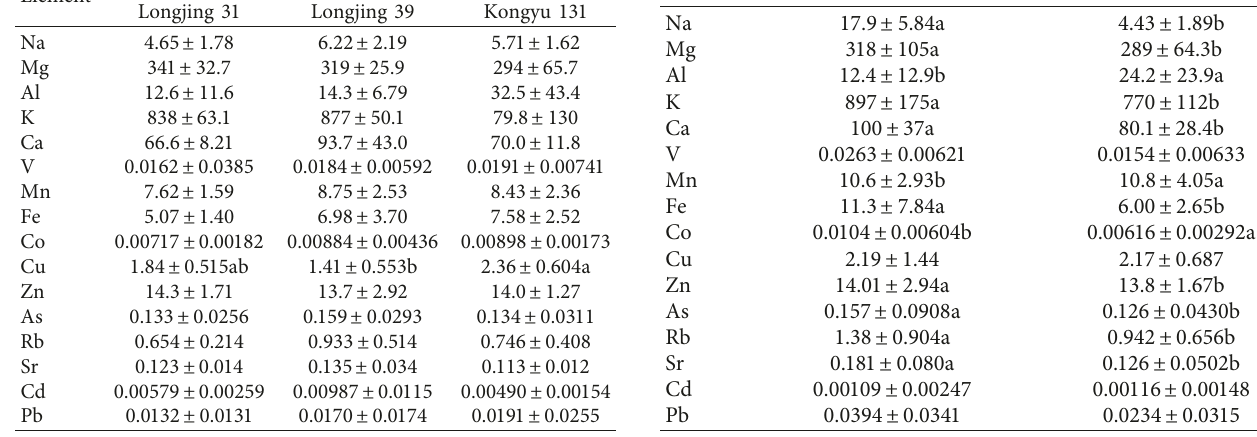
Different letters in rows are statistically significantly different at P < 0 .